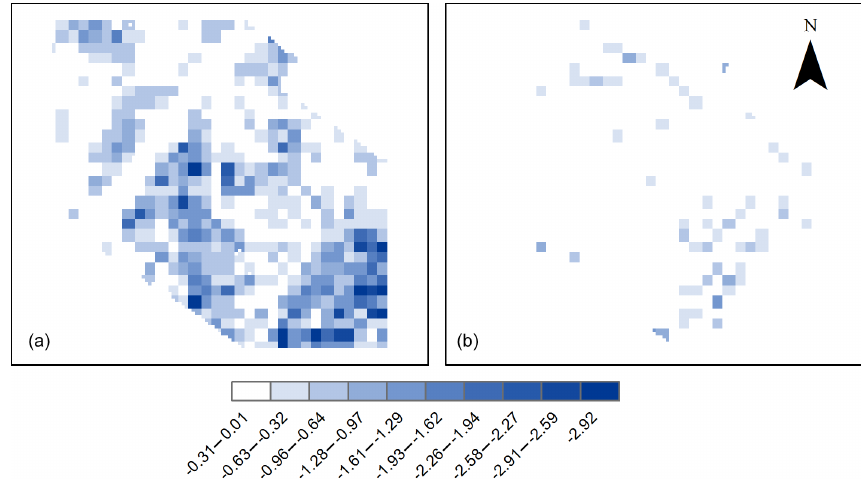
Figure 10. The (cid:49)T ac ( ◦ C) for 2 × TREE − BASE at (a) 15:00 and (b) 03:00 for the Mawson Lakes domain. Table 2. Summary of domain average cooling impacts ( ◦ C) for GBI heat mitigation scenarios.